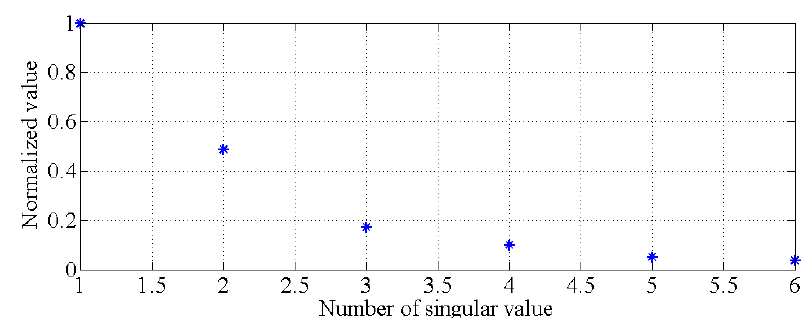
Figure 17. Singular values for determining the principal components of an actual bridge.